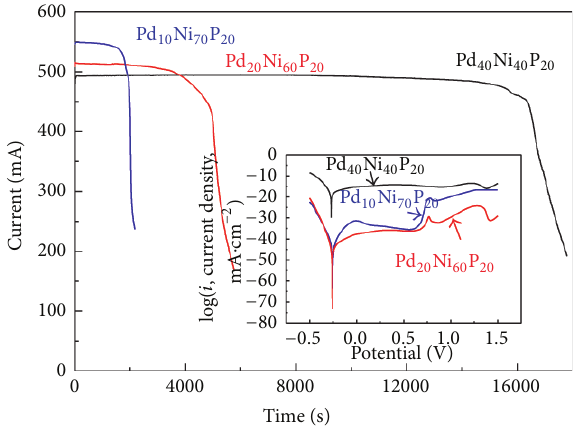
Figure 2: Chronoamperometric (current density versus time) curves for the potentiostatic dealloying of the Pd 𝑥 Ni 80−𝑥 P 20 metallic glasses in 0.8 M H 2 SO 4 + 0.2 M H 3 PO 4 solution at 0.80 V and the inset is the polarization curves of Pd 𝑥 Ni 80−𝑥 P 20 metallic glasses in 0.8 M H 2 SO 4 + 0.2 M H 3 PO 4